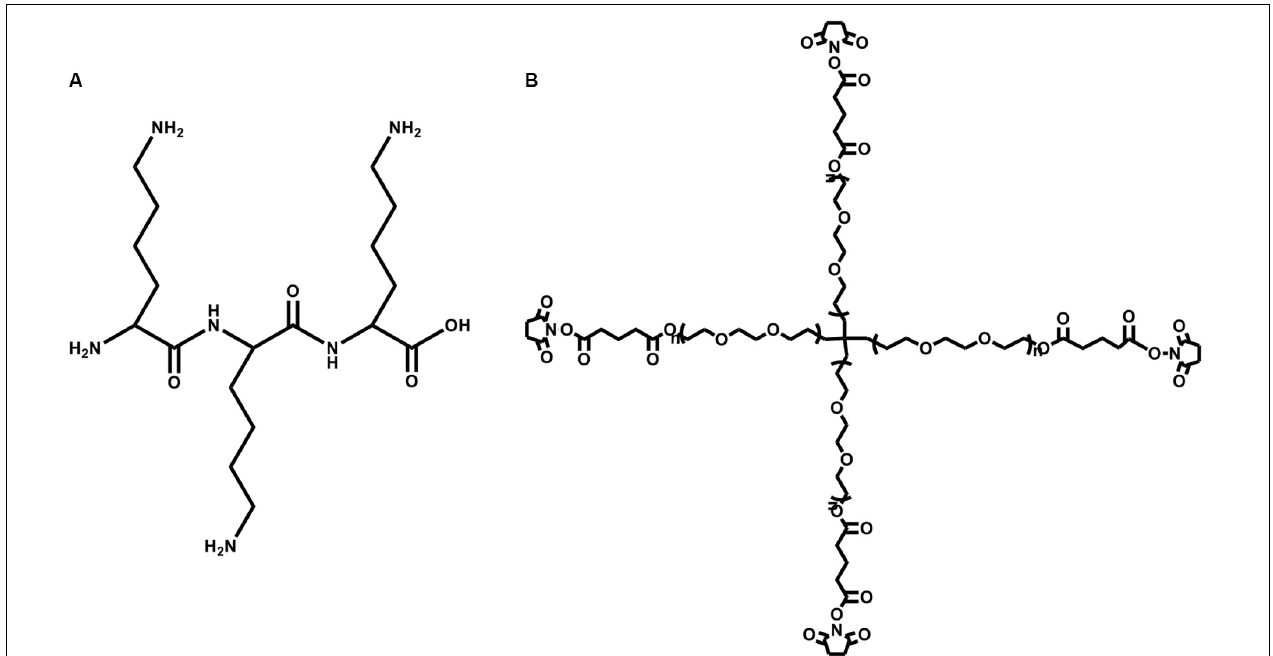
FIGURE 3 | The structures of (A) trilysine and (B) pentaerythritol poly(ethylene glycol) ether succinimidyl glutarate.